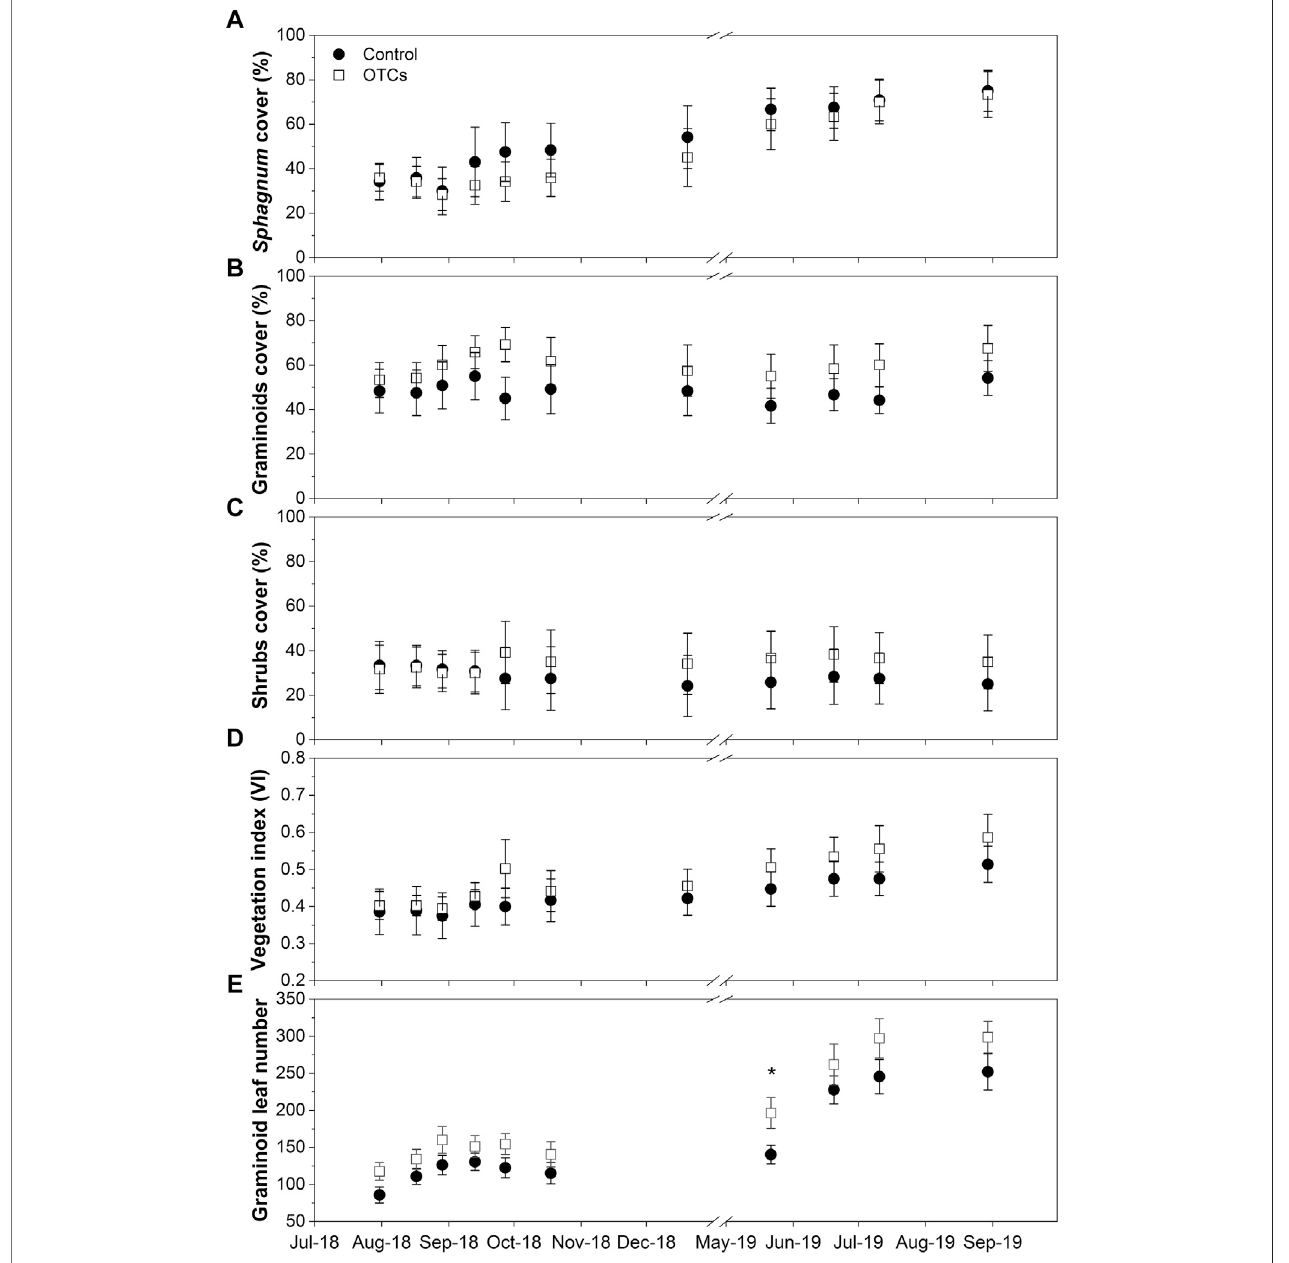
FIGURE1| Percentagecover(%)of (A) bryophytes( Sphagnum ), (B) graminoids( Moliniacaerulea and Eriophorumangustifolium ),and (C) ericaceousshrubs( Erica tetralix and Calluna vulgaris and (D) vegetation index (VI) and (E) the number of graminoid leaves from August 2018 to September 2019. Signi fi cant differences are expressed as * p < 0.05, ** p < 0.01, and *** p < 0.001.